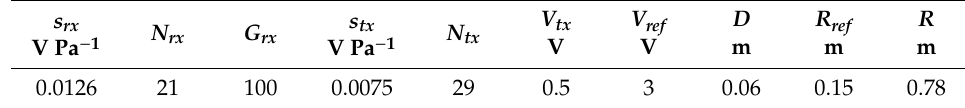
Figure 2 . The grass blade segment. Table 1 . Calibration parameters